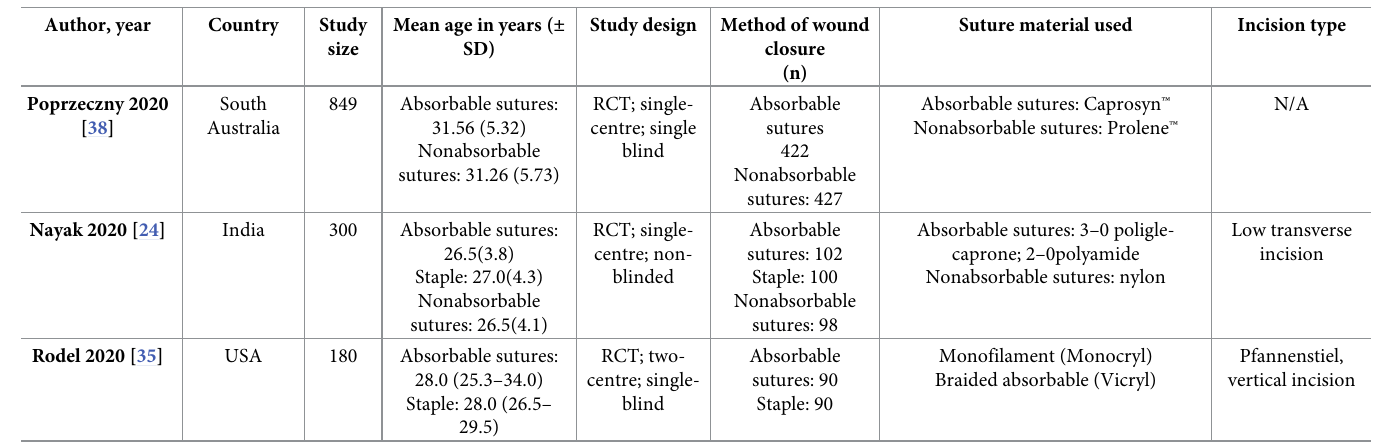
iterations, the PSRF value was 1, which indicated that approximate convergence was achieved. Pooled network OR values indicated that the absorbable suture (network OR, 0.37; 95% CrI: 0.19 to 0.70) were superior to staple (Fig 4C). Despite being equivalent to glue suture, the sur- face score under the cumulative ranking curve analysis (SUCRA) showed that the top-ranked intervention for skin separation were barbed suture (SUCRA score: 58.6, network OR: 0.11, 95% CrI: 0.00–14.35; Fig